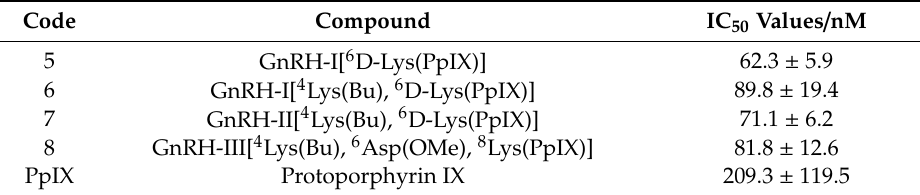
Figure 7. In vitro cell viability inhibition effect of the prepared GnRH-PpIX conjugates (compounds 5 – 8 ) and PpIX using 5 h incubation and a 10 min irradiation period. Cell viability values are present in % of DMSO control. (* p < 0.05; ** p < 0.01; *** p < 0.001). Table 3. Calculated IC 50 values of the prepared conjugates and PpIX.